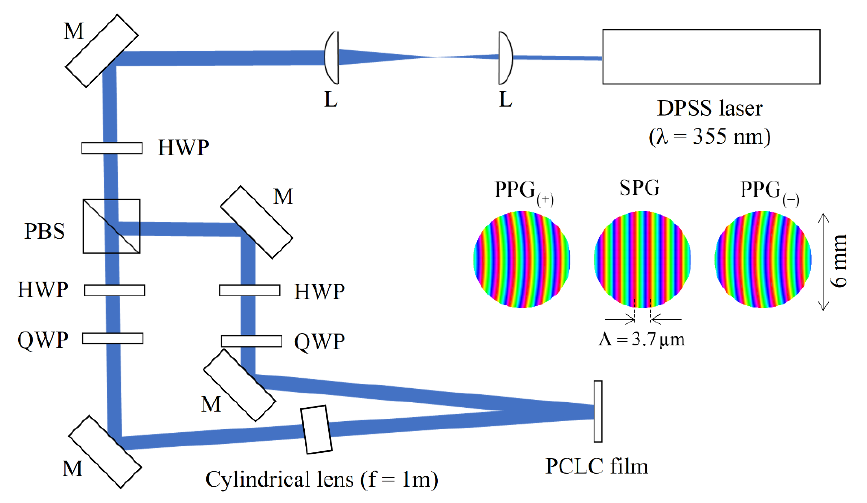
Figure 3. Optical setup for fabricating SPG and PPGs from PPLC by photoalignment.